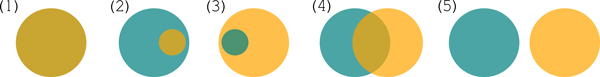
Overlap groups obtained when comparing both mappings directly. Shows the different types of obtained overlap while directly comparing the mappings generated by both methods, regardless of the ontology the mapping is provided for. The amount of mapped concepts for the formal definitions method is represented with a yellow circle and the lexical matching is illustrated with a turquoise circle. We identified the following five categories: a) exact (both lexical matching and formal definitions method generated exactly the same list of mapped concepts), b) formal ⊂ lexical (mapping generated by the formal definitions method is a subset of the list generated by lexical matching), c) lexical ⊂ formal (mapping generated by lexical matching is a subset of the list generated by the formal definitions method), d) overlap (both lists contain additionally mapped concepts and share only a certain overlap), and e) nothing (despite both methods generating a list of mapped concepts for a specific concept, both lists have nothing in common).